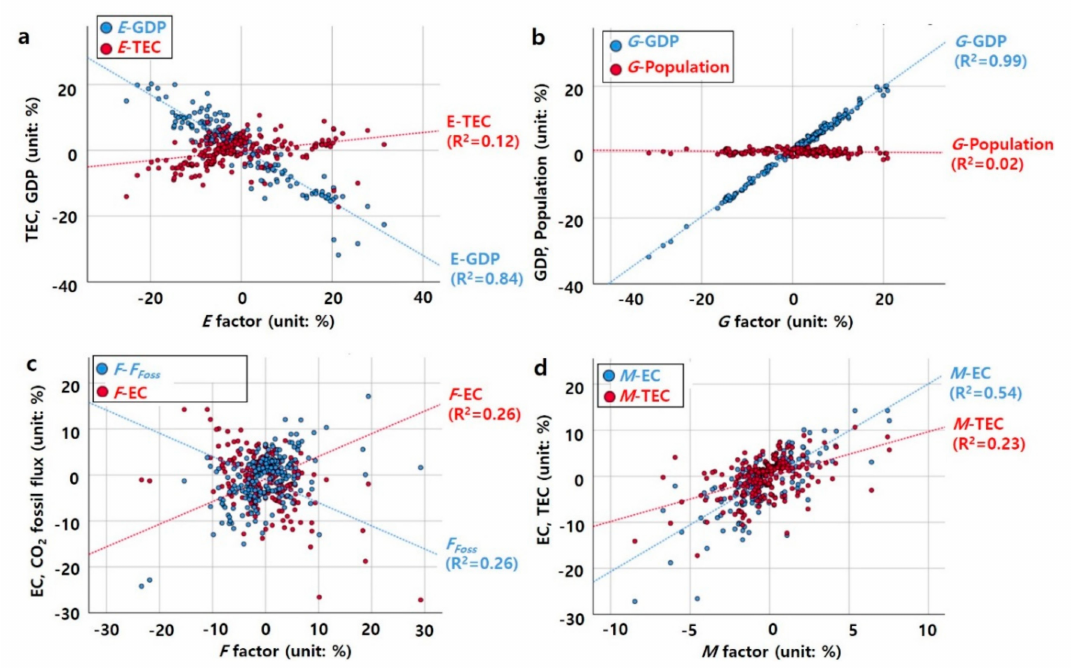
Figure 4. Scatter plots of proportional growth rates of decomposed variables (x axis) and Kaya identity factors (y axis). ( a ) TEC and GDP versus E, ( b ) GDP and population versus G, ( c ) F Foss and GDP versus F, and ( d ) TEC and EC versus